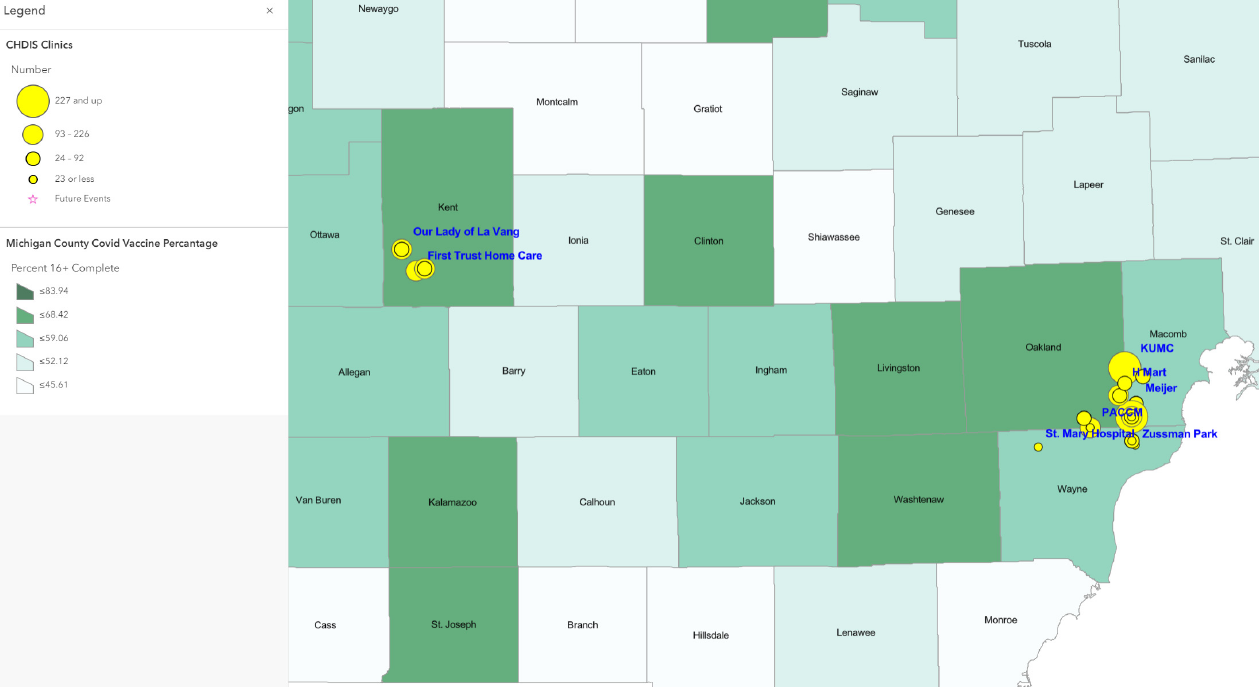
Figure 4. EMU mobile clinics vs. percent of population with no health insurance coverage.